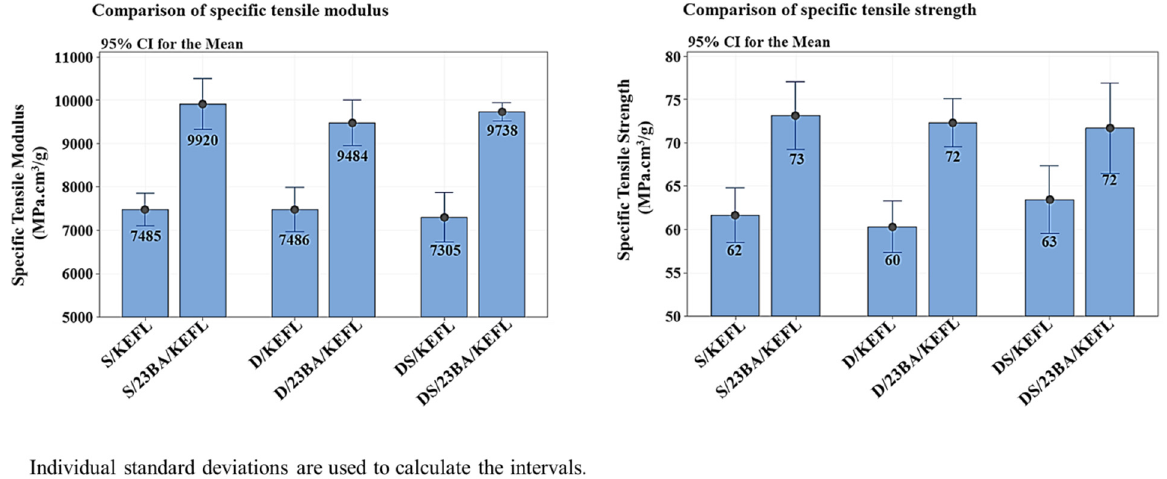
Figure 9. Comparison of specific tensile modulus and strength of composites.